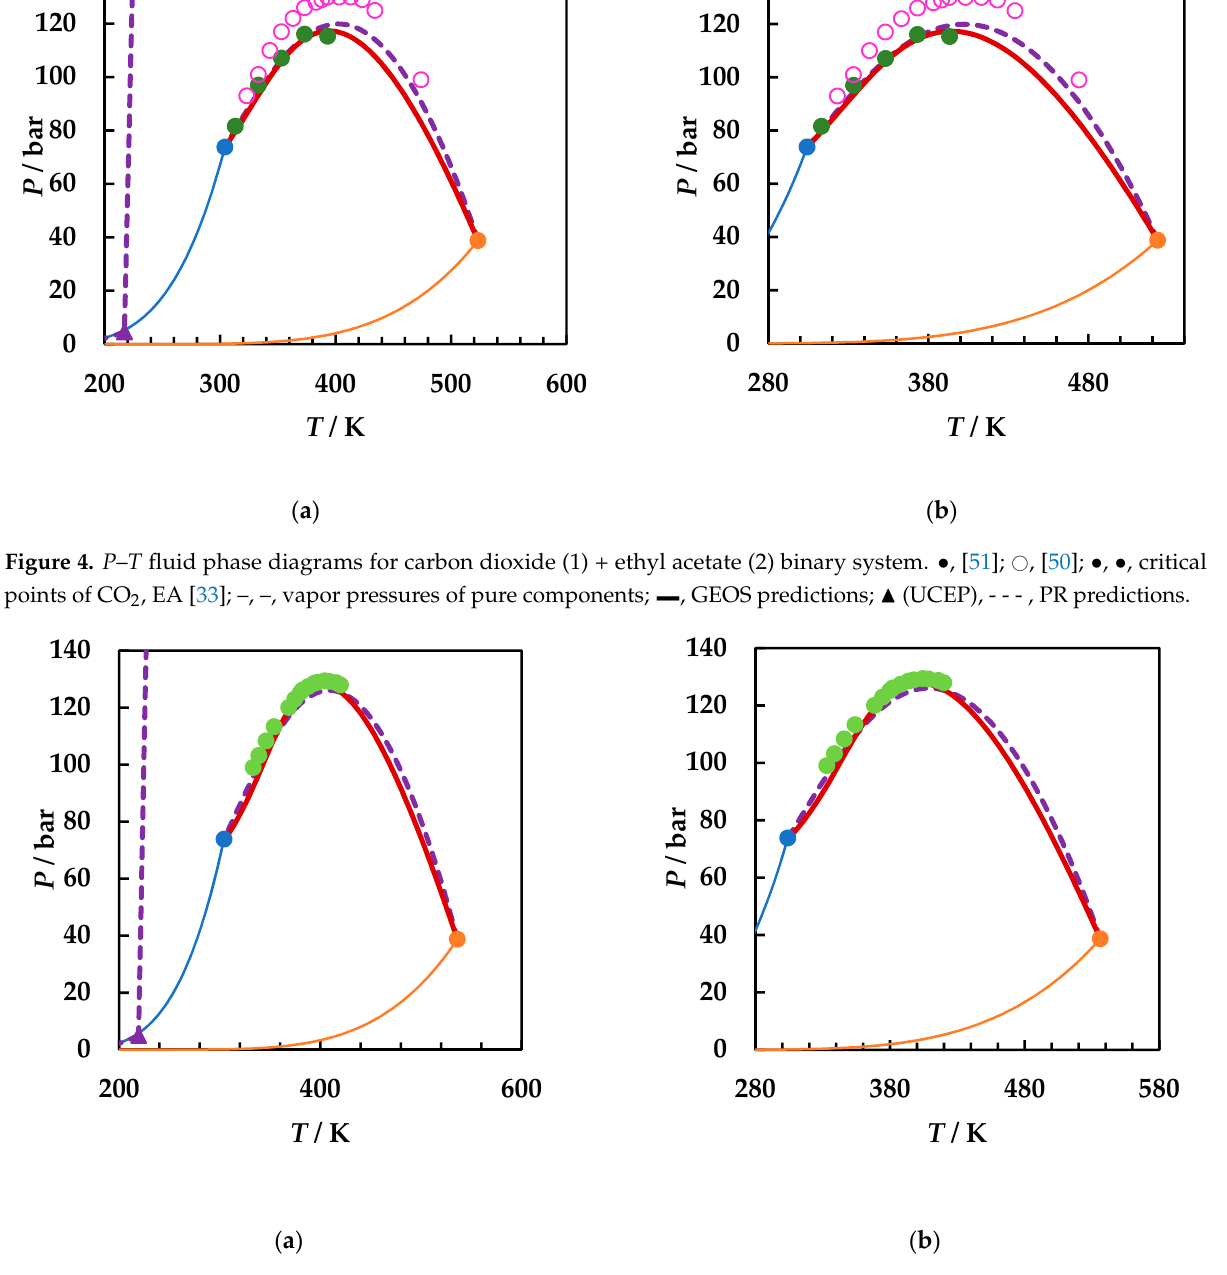
Figure 5. P – T fluid phase diagrams for carbon dioxide (1) + 1,2-dimethoxyethane ( 2 ) binary system. ● , [22]; ● , ● , critical points of CO 2 , EA [33]; ─ , ─ , vapor pressures of pure components; ▬ , GEOS predictions; ▲ (UCEP) , - - - , PR